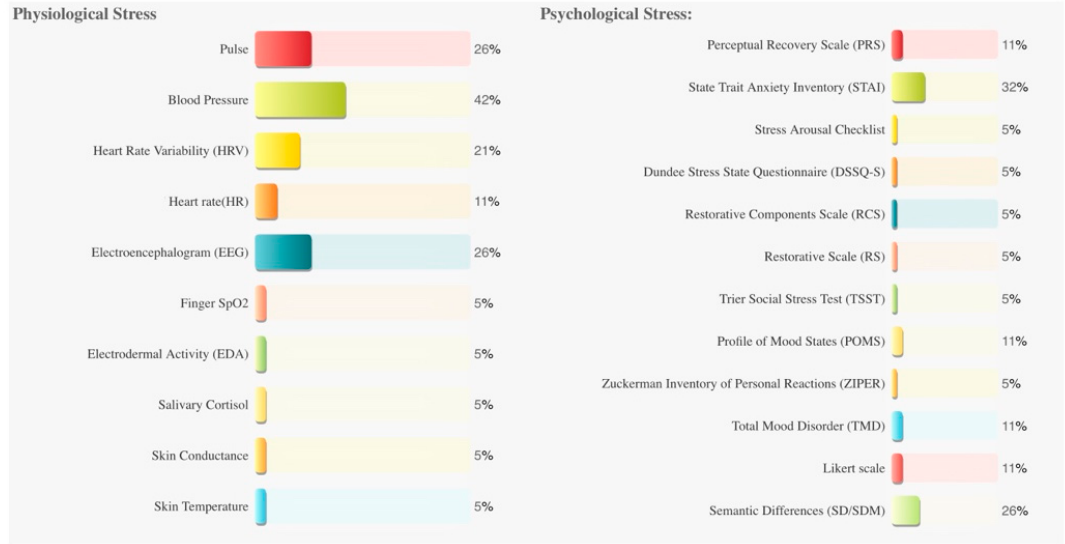
Figure 2. The measurement methods and frequencies of the included studies.